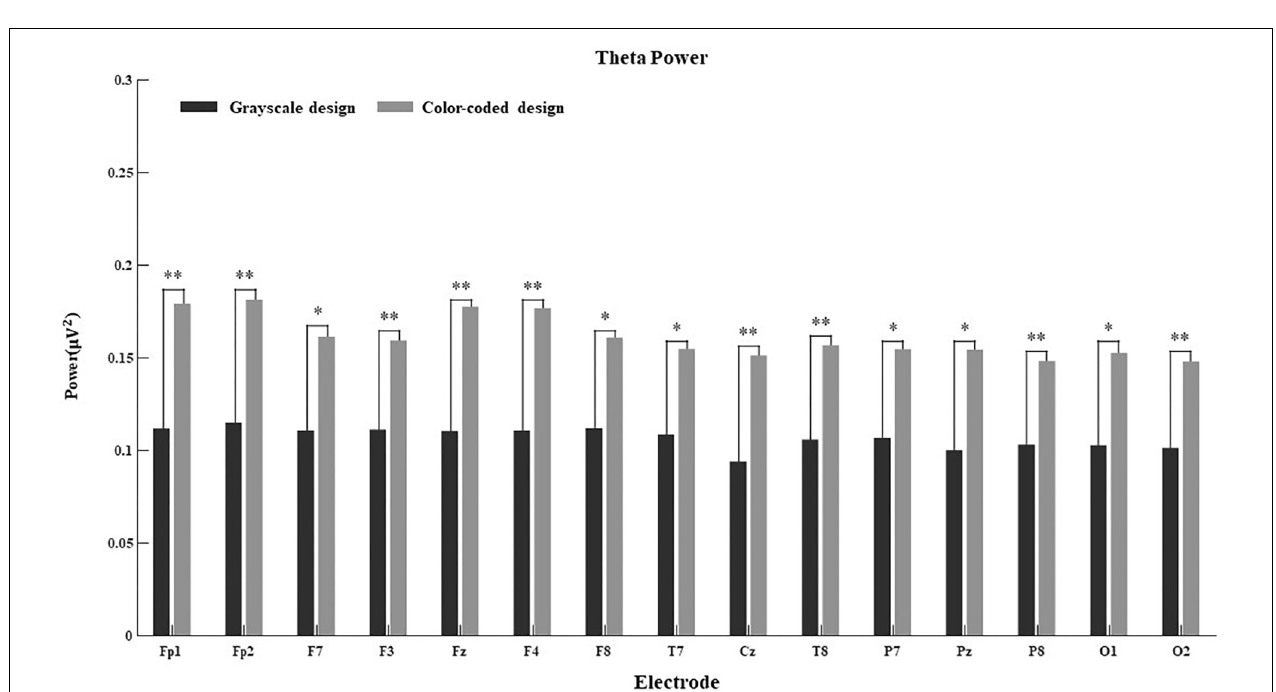
FIGURE 4 | Delta power for the 15 electrodes in the grayscale and color-coded conditions while watching video lectures.